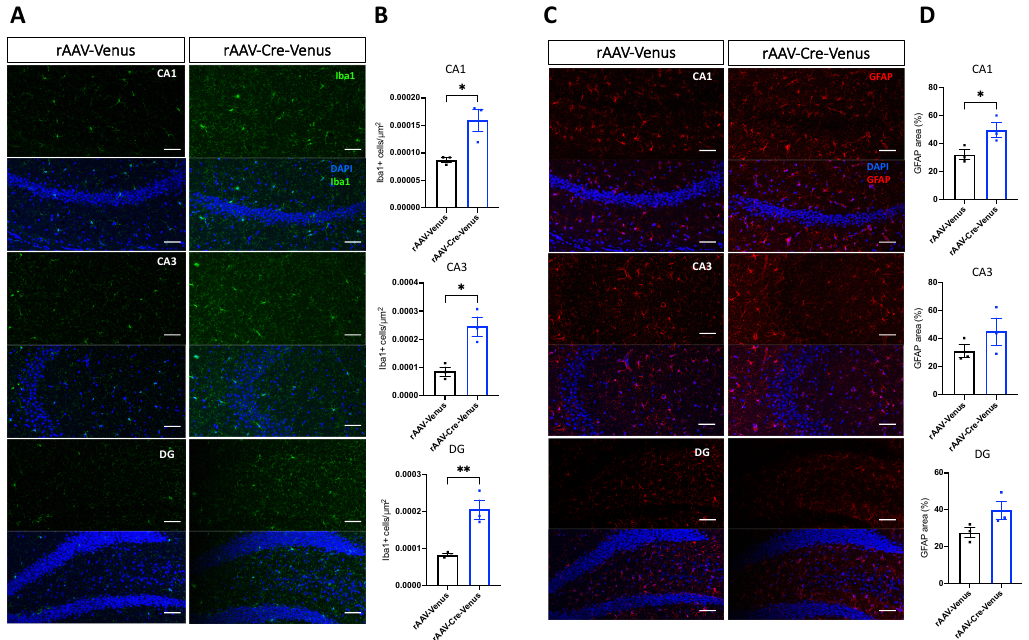
Figure 2. ( A , C ) Representative confocal photomicrographs of Iba1 (green), GFAP (red) and DAPI (blue) immunostaining in the cornu ammonis 1 (CA1), in the cornu ammonis 3 (CA3) and in the dentate gyrus (DG) regions of the hippocampus and ( B , D ) their quantification. Scale bar 50 µ m. Individual data points and mean value ± SEM are shown. Student’s unpaired t -test. * p < 0.05; ** p <